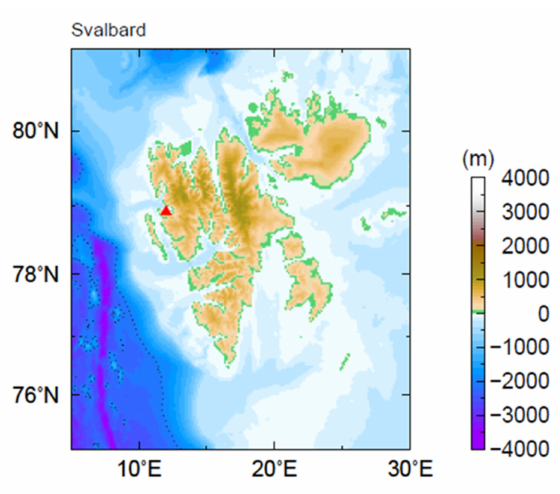
Figure 1. Geographical topographic map of Svalbard. The red triangle mark represents the location of the ceilometer and MRR2 observation